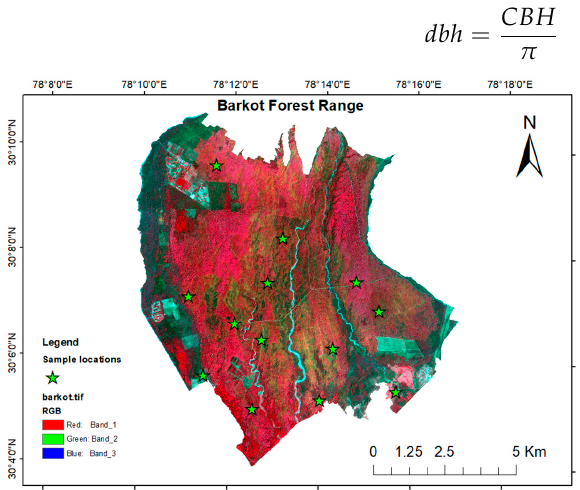
Figure 2. Sampling location of the field data collection.